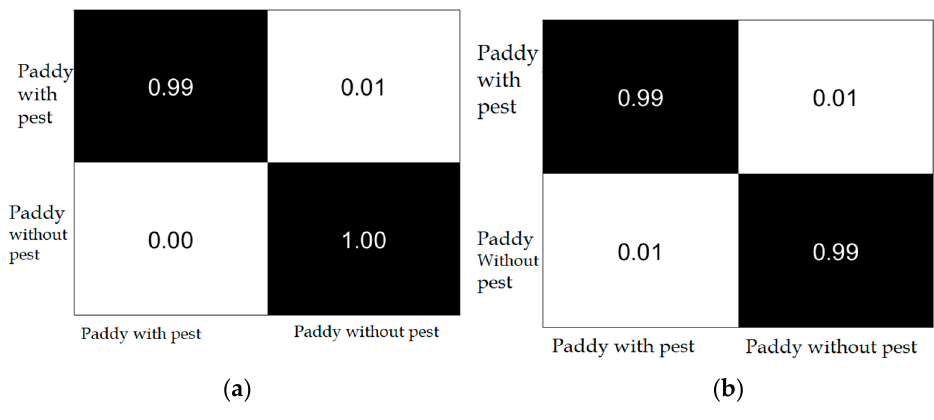
Figure 8. Confusion matrix ( a ) 5-fold; ( b ) 10-fold. Table 6. Classification outcomes using the suggested